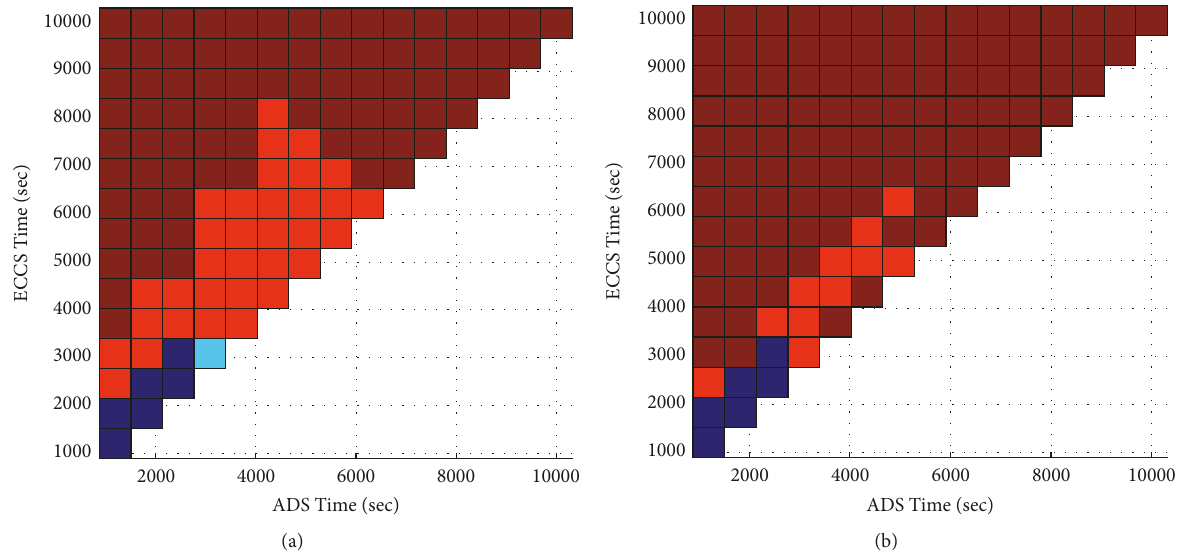
Figure 4: Fuel damage state (a) at the time of water injection (ECCS time) and (b) at the time of transition ( 𝑇 𝑡𝑟 ) as predicted by MELCOR 1.86.